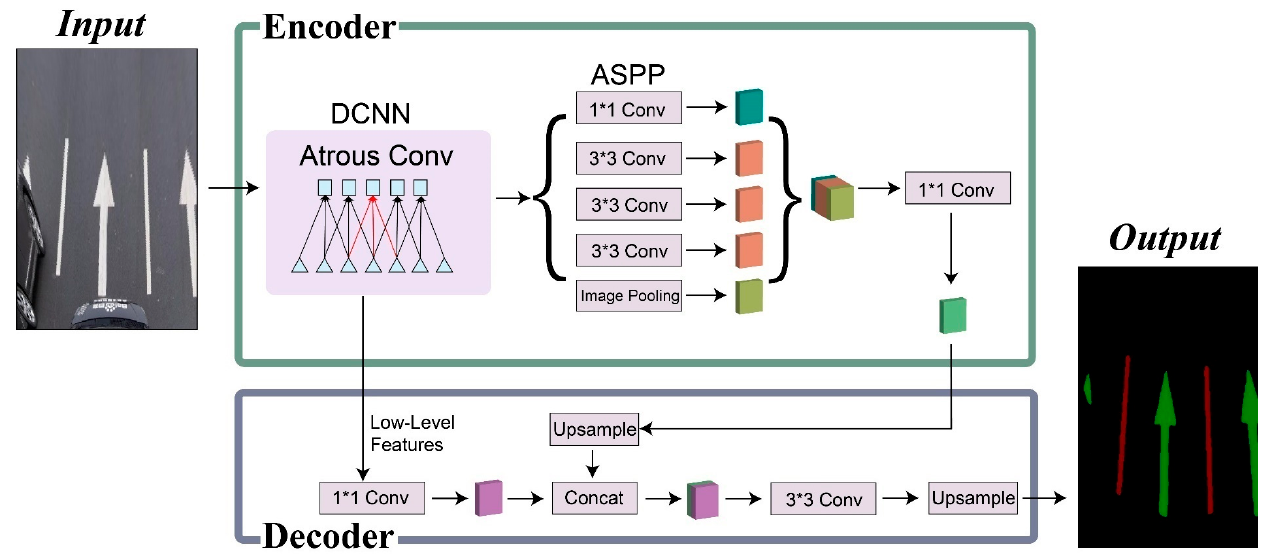
Figure 6. Structure of DeepLab V3+ for segmentation of pavement markings.